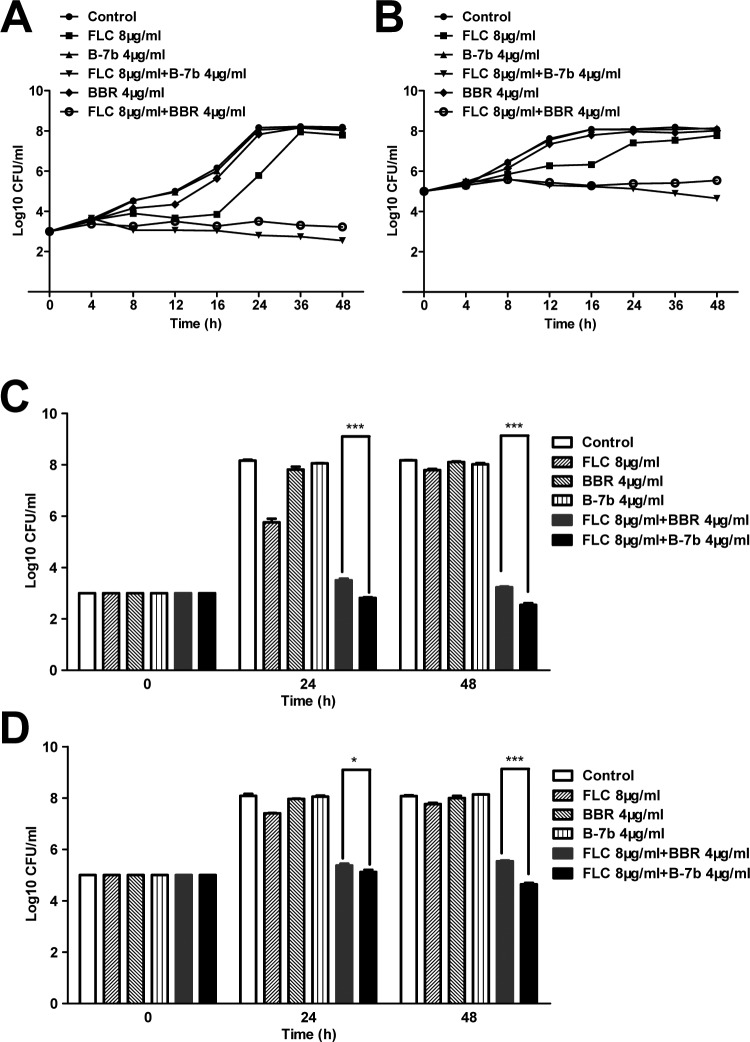
Time killing curves of C. albicans 103 treated with different concentrations of B-7b, BBR and FLC.FLC-resistant C. albicans 103 were treated with FLC (8 μg/ml), B-7b (4 μg/ml), BBR (4 μg/ml), FLC+ B-7b (8+4) μg/ml and FLC+ BBR (8+4) μg/ml by using initial inoculums of 103 CFU/ml (A, C) and 105 CFU/ml (B, D). Aliquots were obtained at the indicated time points and serially dilutions were spread on agar plates. Colony counts were determined after 48h incubation.